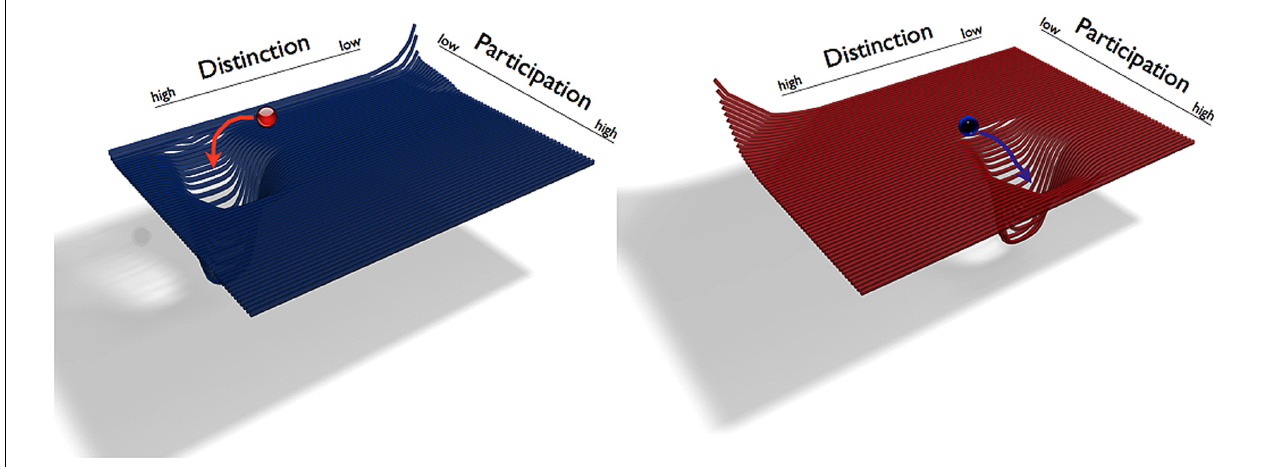
FIGURE 1 | An illustration of two generic individual phase spaces of the enactive self. The individual self states are symbolized as red and blue balls. Their respective phase spaces are spanned by the variables of Distinction D and Participation P . The attractors are wells in D/P landscape, into which the self systems move. The red and blue arrows